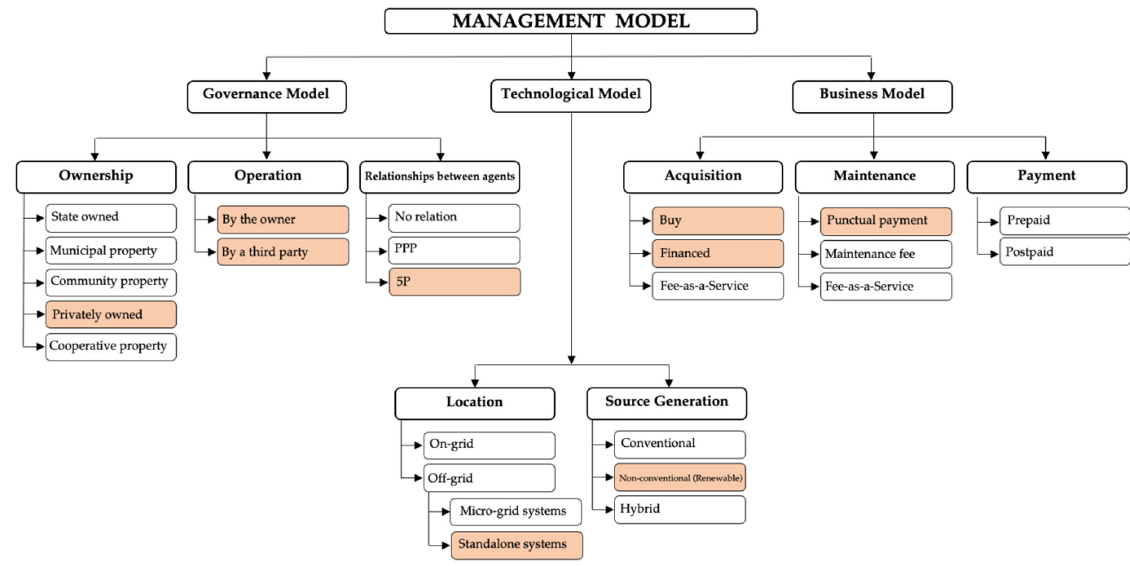
Figure 3. Configuration of the management model of the “Luz en Casa Oaxaca” project.